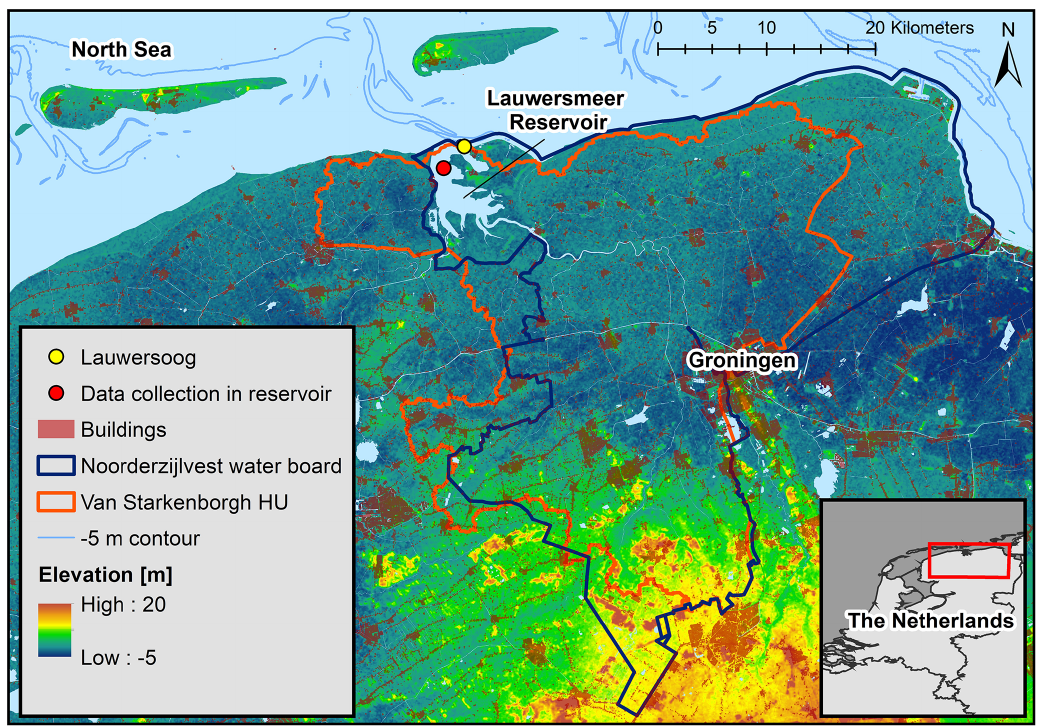
Figure 1. Overview of study site, including elevation around the area, approximate location of data collection sites, and extent of the hydrological unit (HU) and the water board that Lauwersmeer reservoir belongs to. The station Lauwersoog (yellow dot) measures the surge, and the IWL is observed inside the reservoir (red dot indicates approximate location of data collection). The bottom-right panel shows where the study site is situated in the